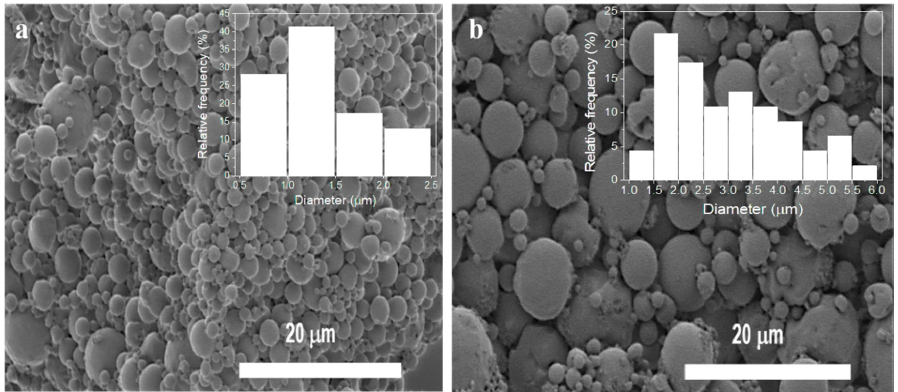
Figure 2. Morphology of ( a ) neat and ( b ) magnetic microspheres and corresponding size distribution obtained by SEM and ImageJ software, respectively.